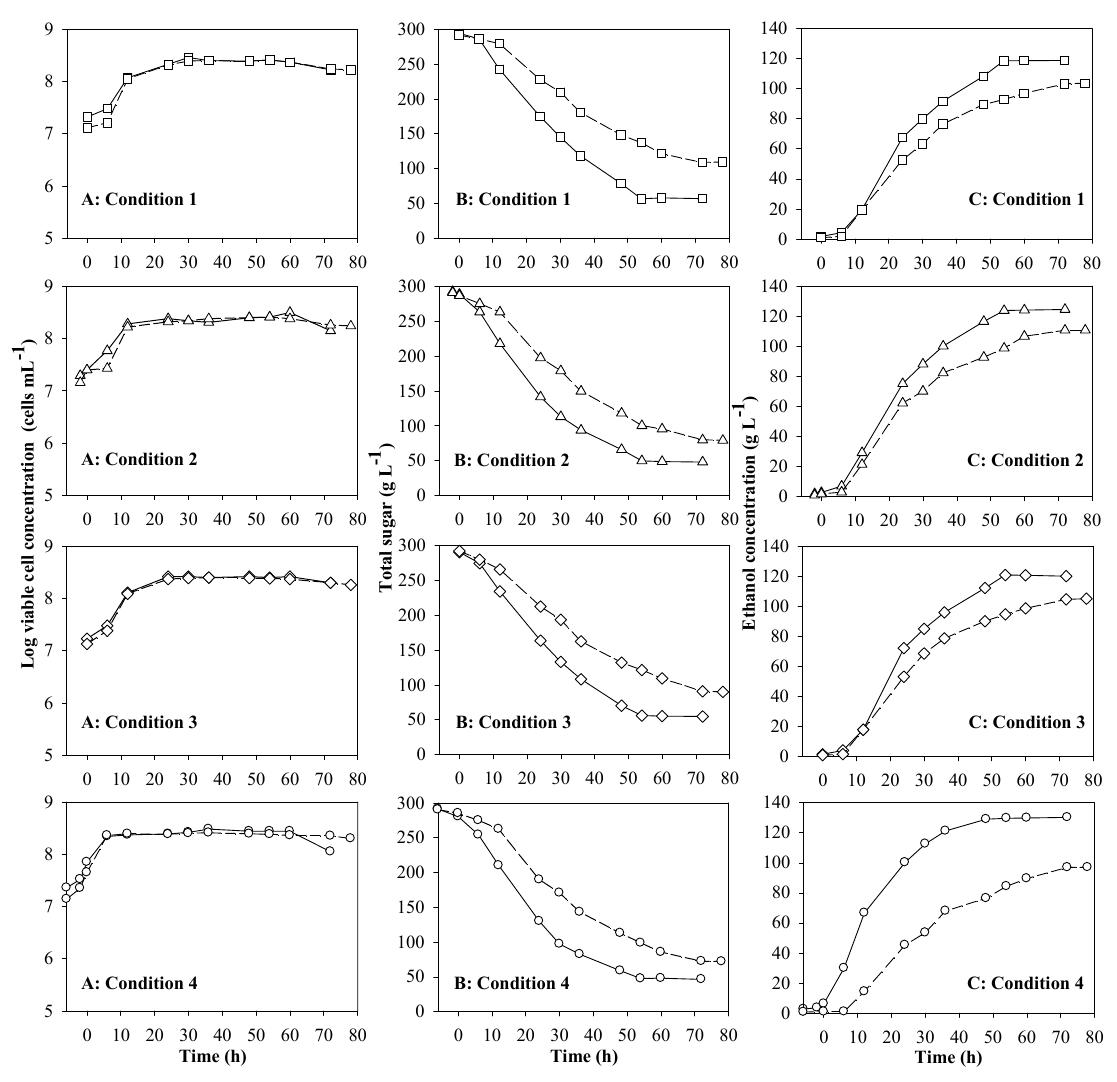
Figure 1. Batch ethanol fermentation from the sweet sorghum juice with ( ⎯ ) and without (- - -) 9 g L − 1 of yeast extract under the four conditions (see Table 1) of the preliminary experiments: ( A ) = log viable cell concentration; ( B ) = total sugar and ( C ) = ethanol